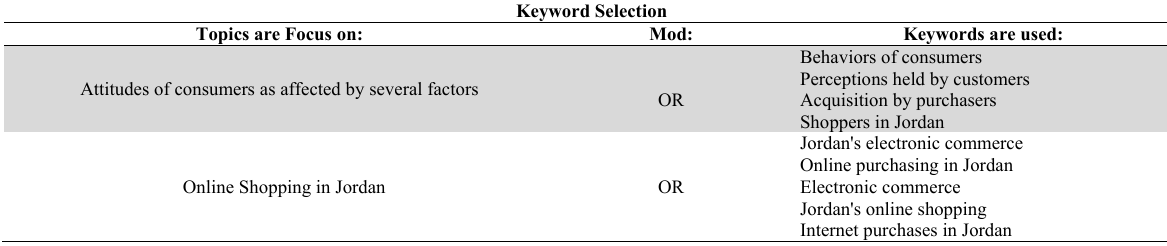
Collecting Information Through the Use of Keywords Keyword Selection Topics are Focus on: Mod: Keywords are